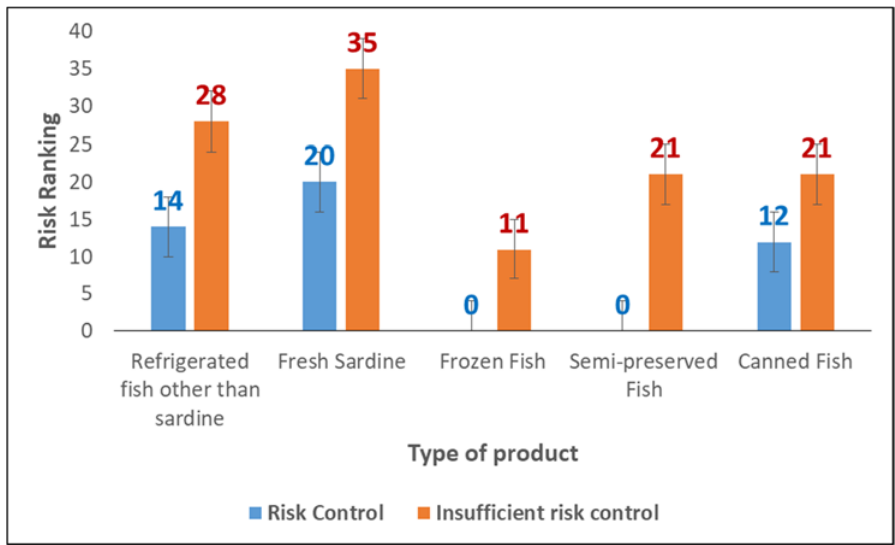
Figure 5. Risk ranking of various categories of fishery products (low- and high-risk ranking of histamine).